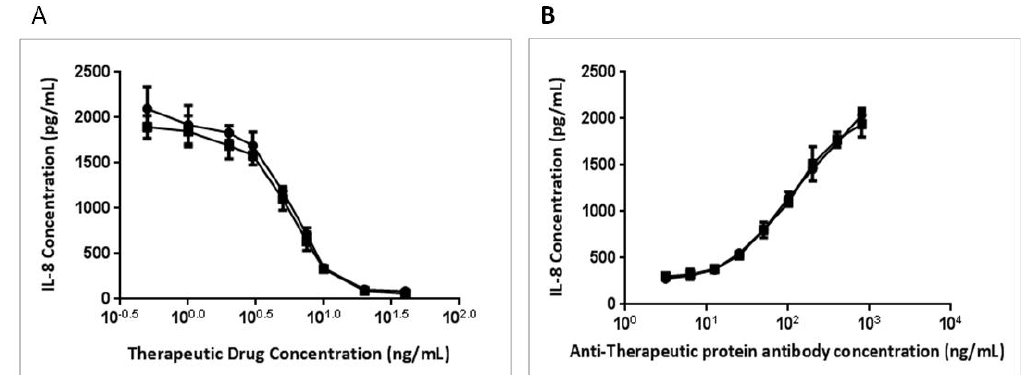
Figure 6. Dose response curves for anti-BAFF therapeutic protein (TP) and anti-TP neutralizing antibody. An anti-BAFF therapeutic protein (TP) (a neutralizing antibody anti-therapeutic protein neutralizing antibody with 10 ng/mL of BAFF and 10 ng/mL of